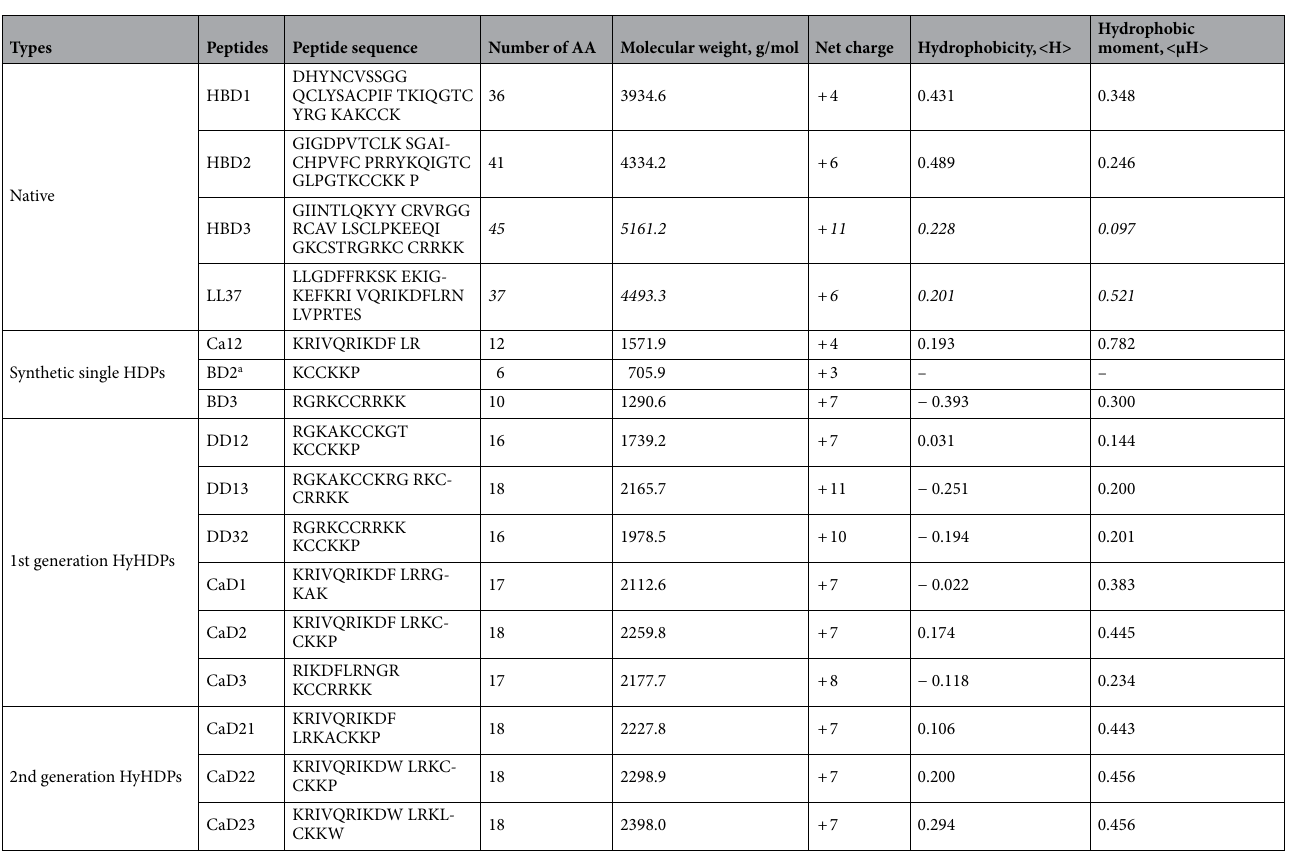
Table 1. Summary of the native and synthetic host defense peptide (HDP) sequences. Calculation of the physicochemical properties of the peptides was performed using PepCalc (https:// pepca lc. com/) and HeliQuest (https:// heliq uest. ipmc. cnrs. fr/ cgi- bin/ Compu tPara ms. py). HBD: human beta-defensin; AA: amino acids; HyHDPs: hybrid host defense peptides; C: cysteine; D: aspartic acid; E: glutamic acid; F: